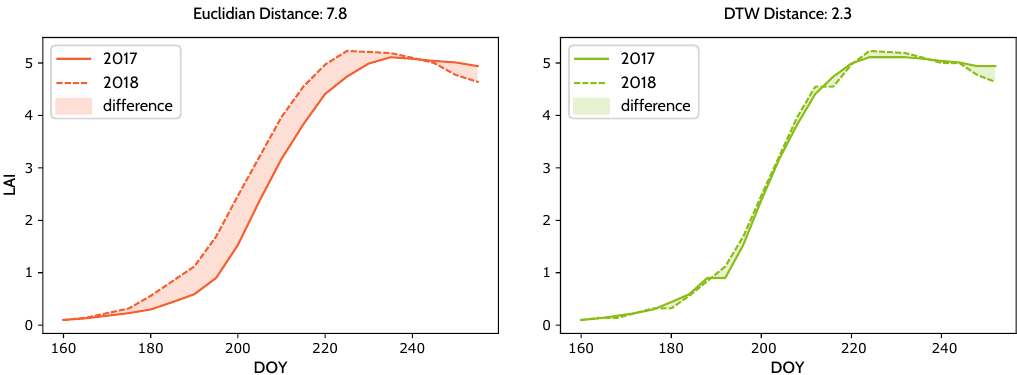
Figure 10. Two healthy and stable LAI series which may be considered to be under stress if we use Euclidian distance. X axis denotes day of year in 2017 and 2018, y axis denotes the LAI value of the pixel. ( Left ): Original series and difference measured by Euclidian distance. ( Right ): Warped series using DTW and difference measured by